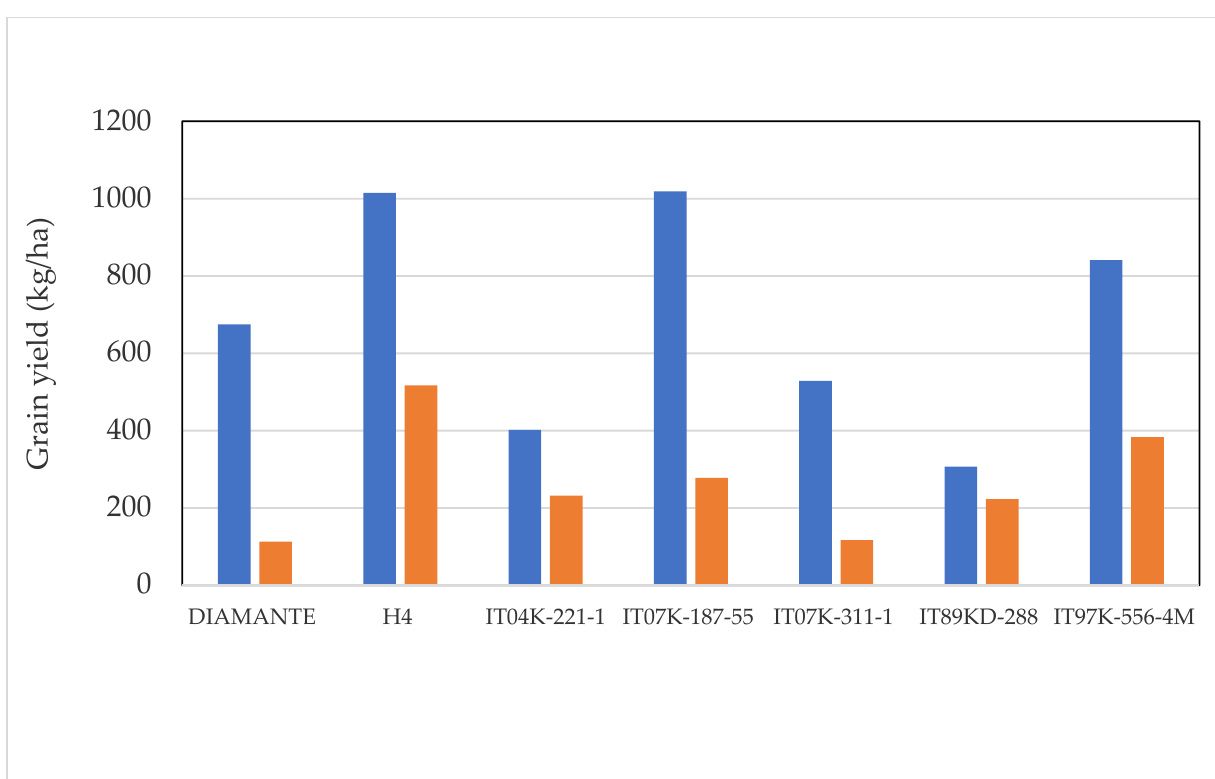
Plants 2021 , 10 , x FOR PEER REVIEW Figure 1. Mean values of grain yield for genotypes treated (blue) and untreated (orange). Table 1. Germination rate for examined genotypes. The average of the genotypes indicated by the letters, are not significantly different at the rate level of 5% and coefficient of variation (CV).